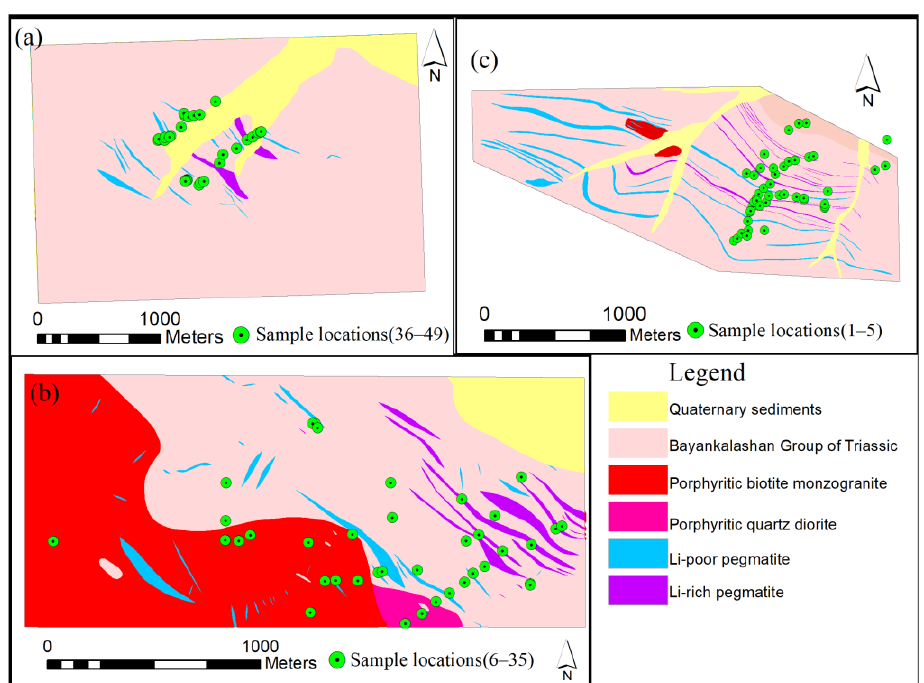
Figure 2. Distribution of the sampling points: ( a ) Akesayi mine, ( b ) the 509 mine, and ( c ) Long- mengshan mine.